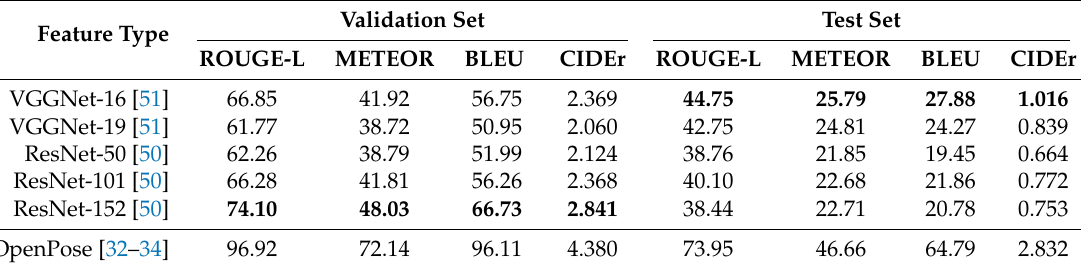
Table 4. Performance comparison with translation models based on CNN-based feature extraction techniques. Note that the augmentation factor in this experiment was all set to